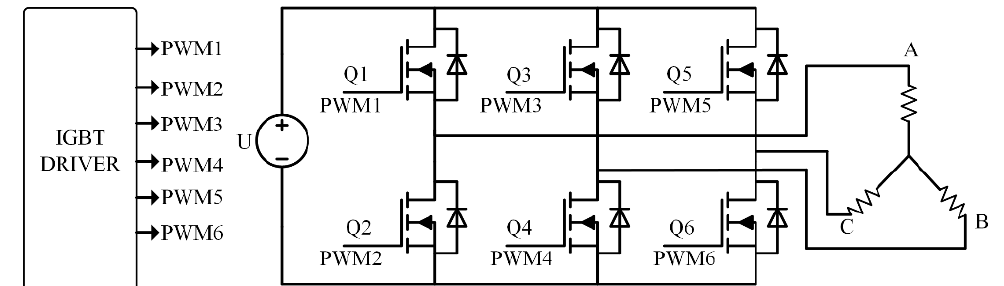
Figure 9. Three-loop control system for the FVVA system.